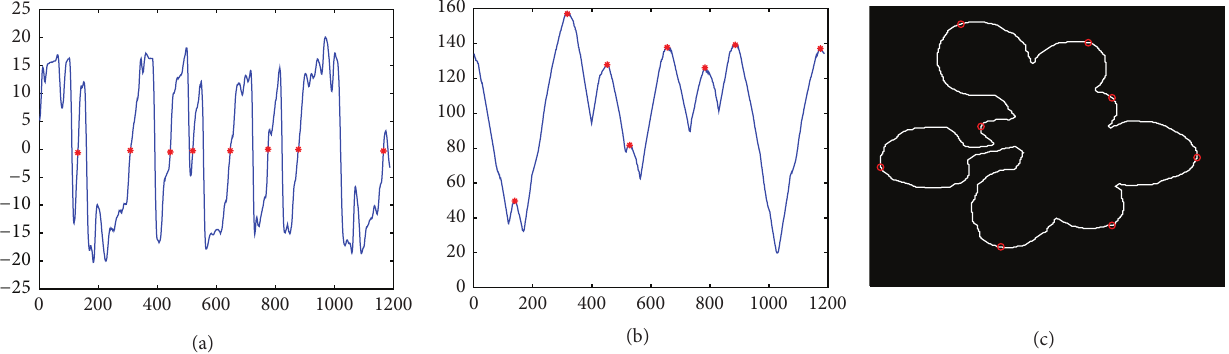
Figure 4: Local maximum recognition. (a) Wavelet coefficients in the fifth level. The zero coefficients are marked with red dots. (b) Distance curve between the contour point and the centroid. The local maximum points are labelled with red dots. (c) The apex of each leaf.